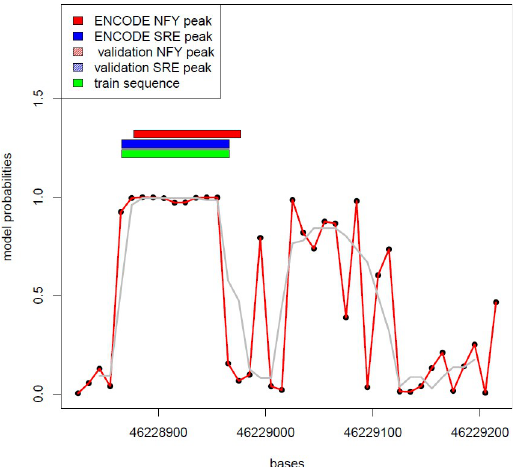
Fig 2. Model probabilities of occurrence of an SRE-NFY couple in the first 500 bases of the Lanosterol Synthase ( LSS ) promoter.